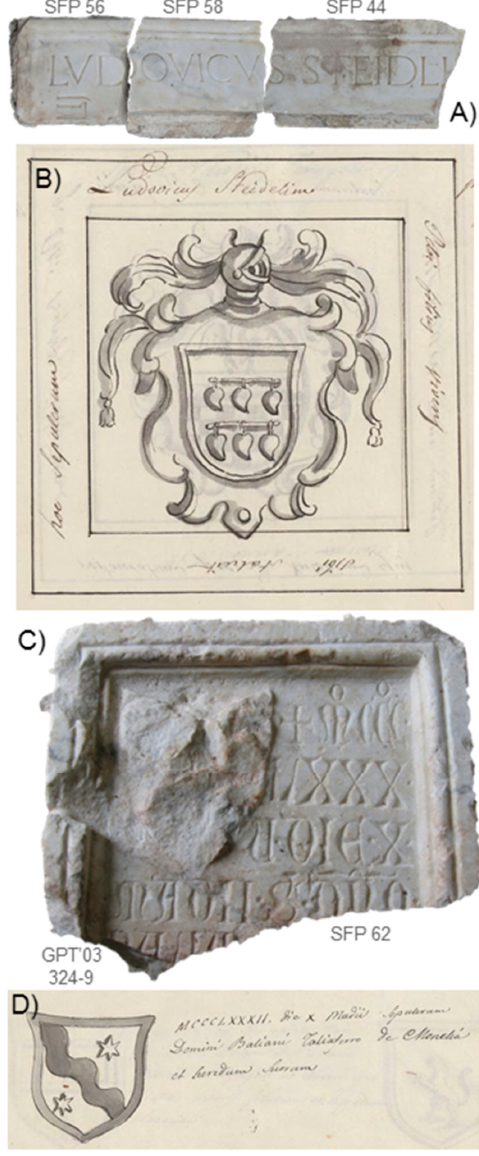
Figure 5. Function reconstruction by comparison with archive sources. ( A ) Epigraph (SFP 44, 56 and 58) reading “LIJ LUDOVICUS STEIDL”. Photography of the fragments is courtesy of the Superintendence of Archaeology, Fine Arts and Landscape for the metropolitan city of Genoa and the provinces of Imperia, La Spezia and Savona (partial or total reproduction is forbidden without prior (written) permission). ( B ) Corresponding drawing inside the manuscript Epitaphia, sepulcra et